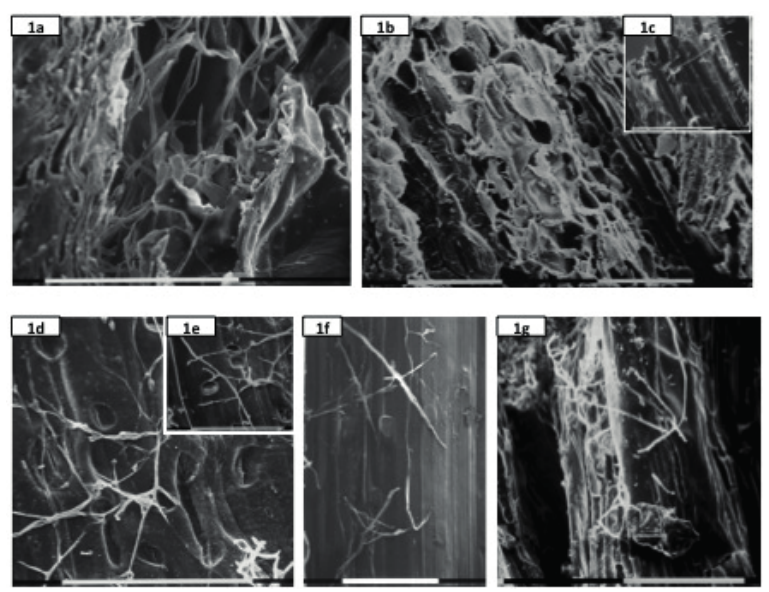
Fig. 1. Scanning electron microscopy micrographs. Detection of fungal colonization in different segments of the stem of barley plants following inoculation with F. culmorum (Fc820), F. graminerum (Fg913) and F. pseudograminearum (CS3427). 1a-1c. Hyphae of F. culmorum (Fc820) on the surface of the stem in the area adjacent to the crown, including the first node (segment I) (1a) and in the area including the second node (segment II) (1b). Detail of hyphae inside the stem in segment II (1c). The epidermal layer, even if with a low hyphal concentration, appears damaged. 1d-1f. Hyphae of F. graminearum (Fg913) in segments I (1d) and II (1f) of the barley stem. In this case, the epidermal layer, even if the hyphal concentration is high, appears well preserved. In the insert (1e) hyphae penetrating a stomata at the level of segment I. 1g. Hyphae of F. pseudograminearum (CS3427) on segment I (1g) of barley stem.